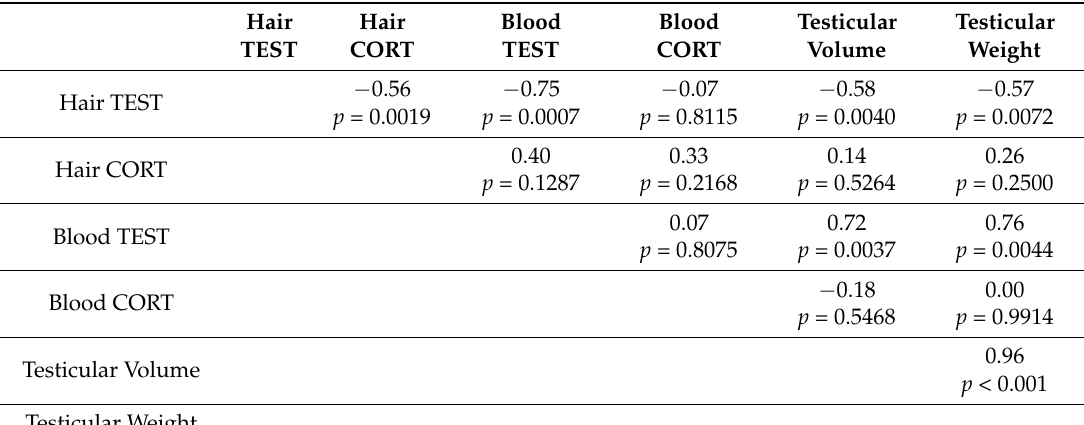
Table 2. Spearman rank correlation coefficients ( ρ ) table with p values (95% C.I.) for all the analyzed